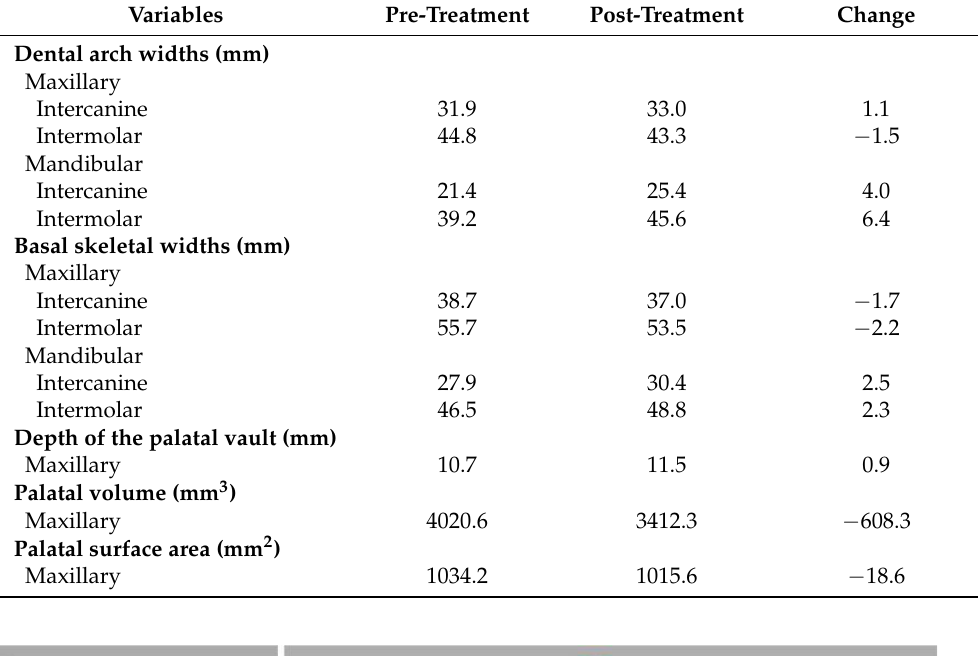
Table 2. Statistics concerning initial and final digital casts.